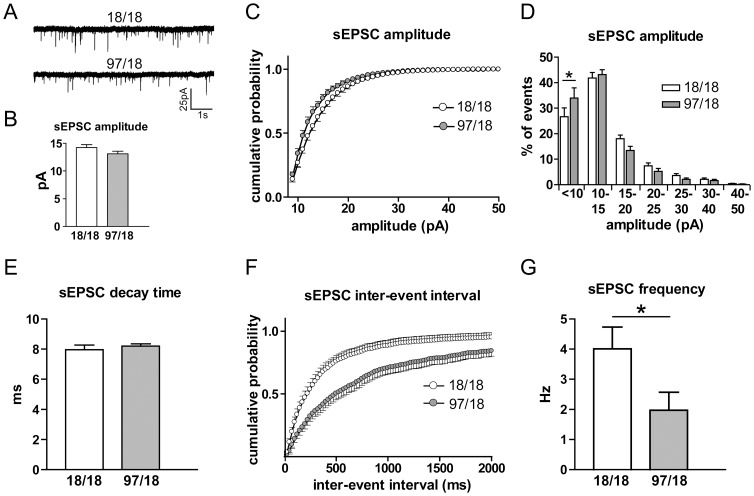
sEPSC amplitude and frequency change in Hu97/18 SPNs.Cells were patch-clamped with a potassium-based internal solution at Vh = -70 mV and sEPSCs were recorded. (A) Representative sEPSC traces for Hu18/18 (top) and Hu97/18 SPNs (bottom). (B) The average sEPSC amplitude of Hu18/18 and Hu97/18 cells (difference did not reach significance, p = 0.12). (C) Cumulative probability showed a decrease in sEPSC amplitude in Hu97/18 SPNs (significant genotype and amplitude interaction, p<0.0001). (D) Amplitude distribution analysis showed a significant increase in the percentage of small events (<10pA) and a trend towards a decrease in big events (>15pA) in Hu97/18 SPNs. (E) There was no difference in sEPSC decay time between Hu18/18 and Hu97/18 SPNs. (F) Cumulative probability showed an increase in sEPSC inter-event intervals in Hu97/18 SPNs (significant genotype and inter-event intervals interaction, p<0.0001). (G) The average sEPSC frequency was decreased in Hu97/18 SPNs (p = 0.038). For all experiments, Hu18/18 n = 20 and Hu97/18 n = 17. *P<0.05 (two-way ANOVA with Bonferroni correction, D; unpaired Student’s t-test, G).